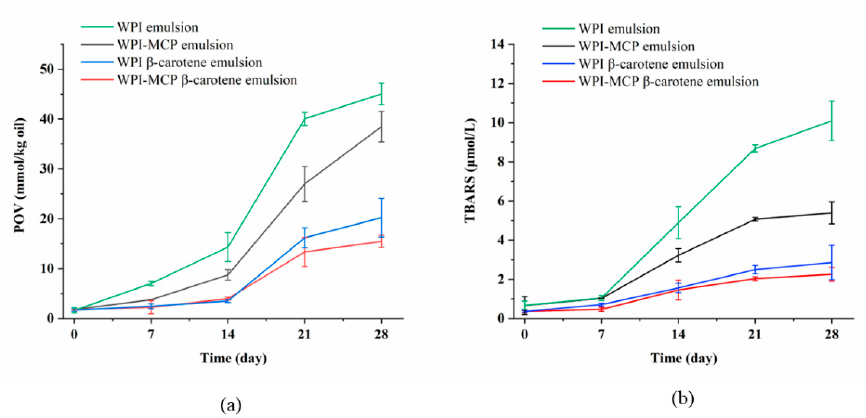
Figure 5. Changes of POV ( a ) and TBARS values ( b ) of different emulsions during 28 days storage.